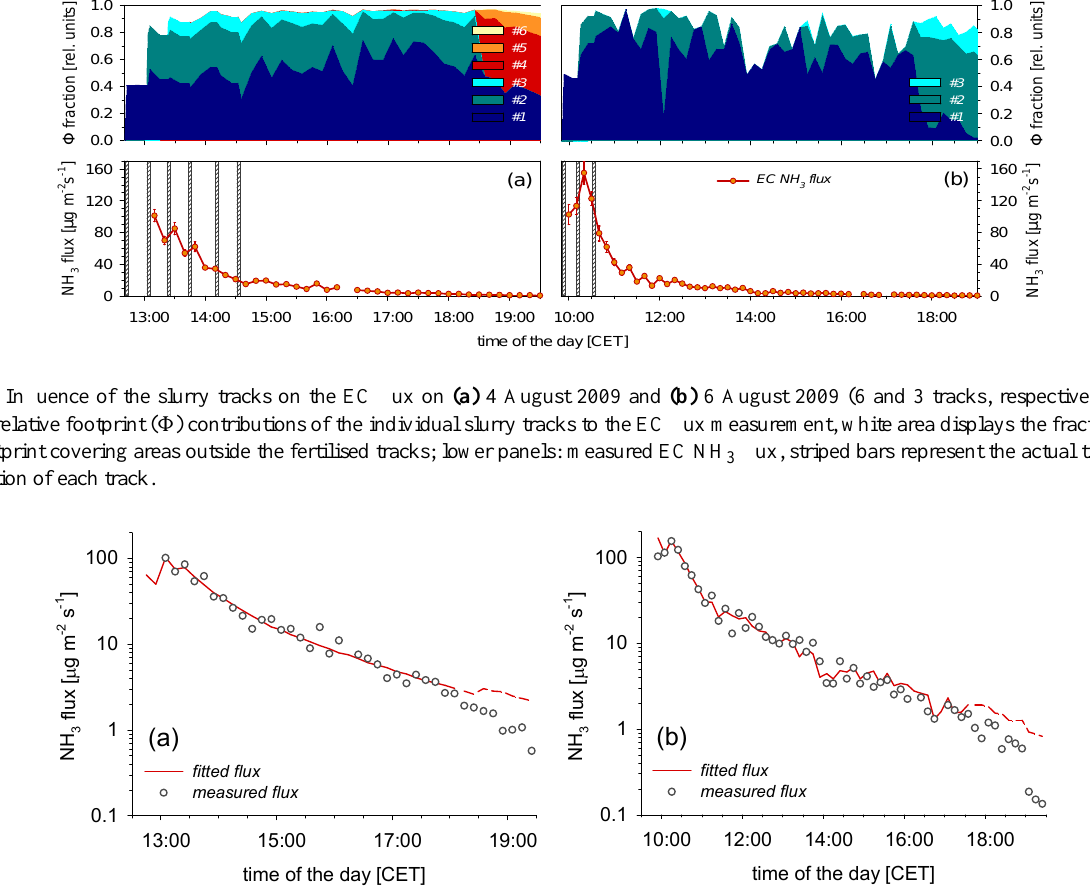
Fig. 5. EC NH 3 fluxes measured and corresponding F EC , fit on (a) 4 August 2009 and (b) 6 August 2009; dashed lines indicate the periods when the parameterisation was regarded not to reflect representative surface emissions anymore, but the field was considered to emit